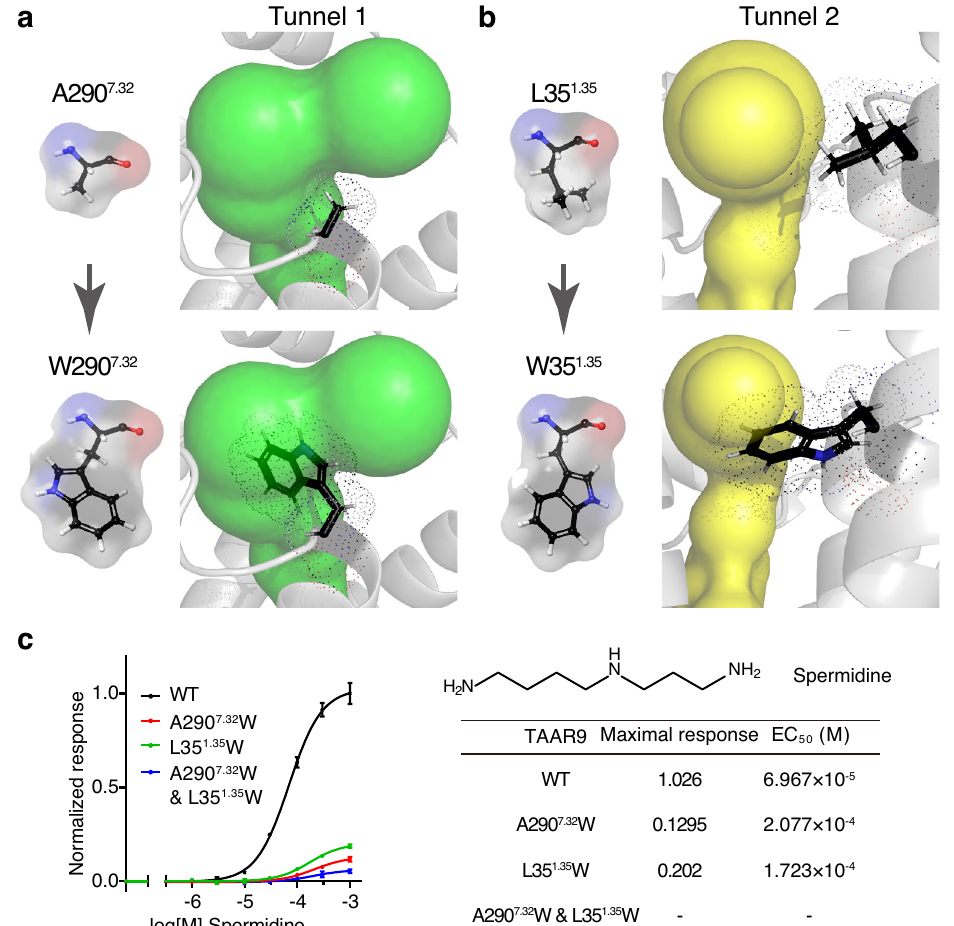
Figure 3. Assessment of the functional role of tunnels. ( a ) Mutation of A290 7.32 to W290 7.32 could lead to high steric hinderance in Tunnel 1 (green). ( b ) Mutation of L35 1.35 to W35 1.35 could lead to high steric hinderance in Tunnel 2 (yellow). ( c ) Dose-dependent response curves of wild type (WT), A290 7.32 W single mutant, L35 1.35 W single mutant, and A290 7.32 W & L35 1.35 W double mutant TAAR9 to spermidine. The A290 7.32 W or L35 1.35 W single mutant shows much lower maximal response and larger EC 50 . The A290 7.32 W & L35 1.35 W double mutant shows further decrease in maximal